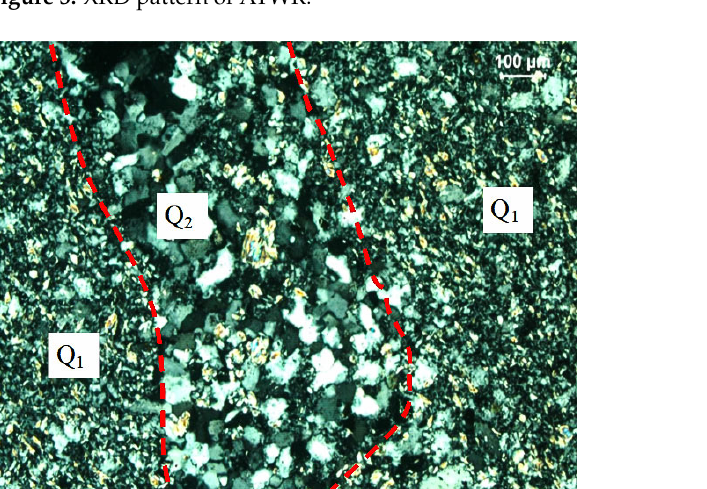
Figure 3. XRD pattern of ATWR.